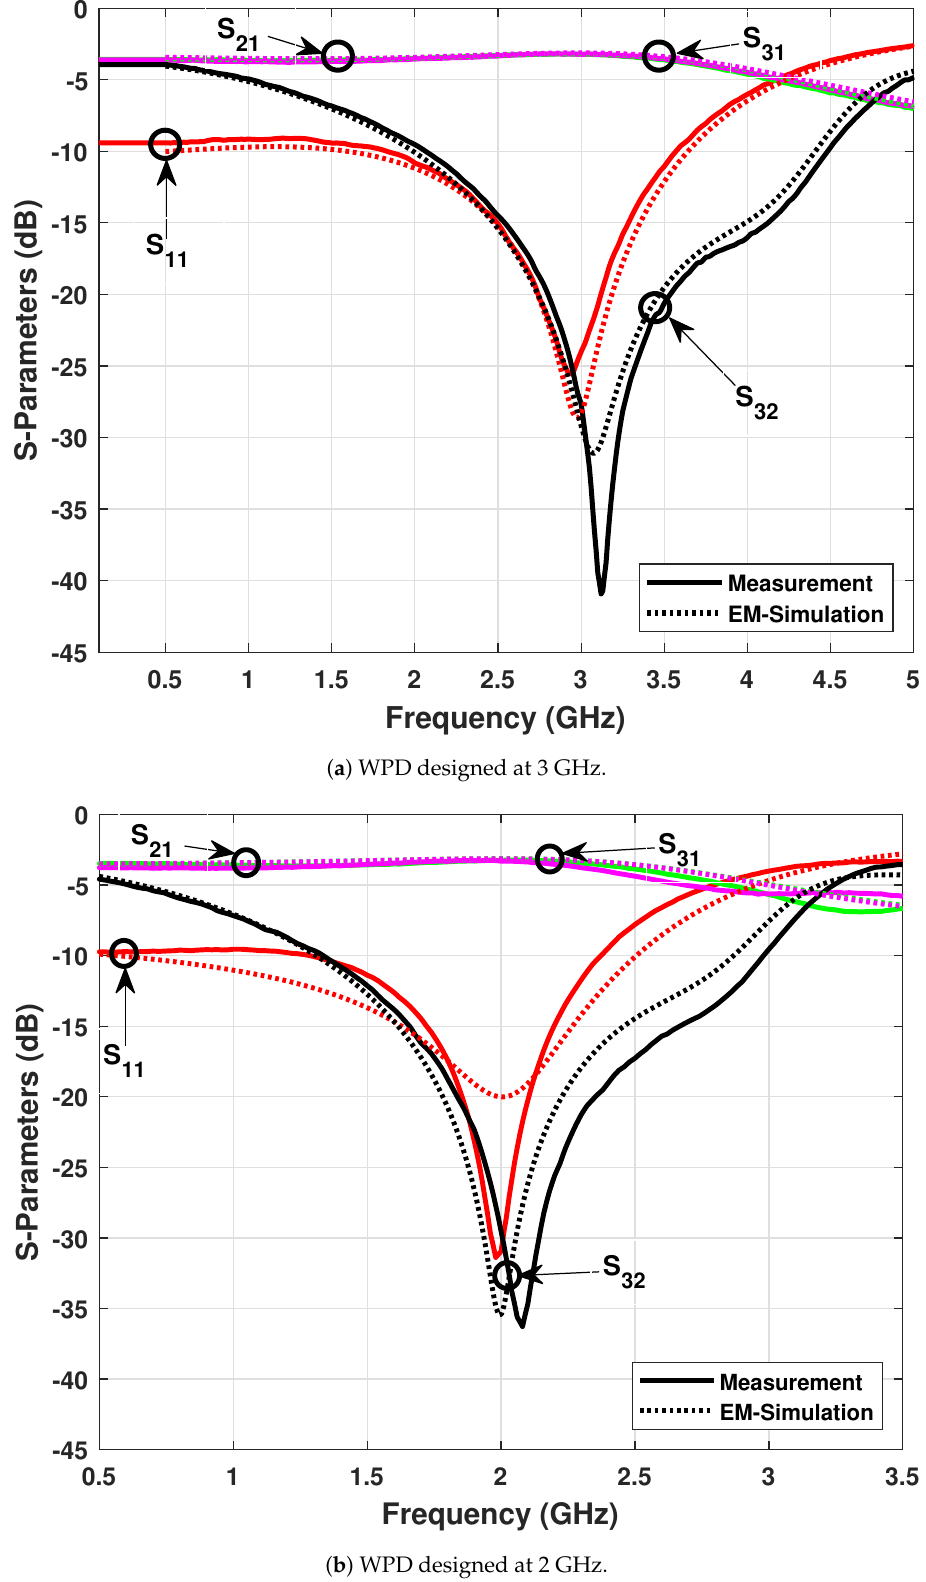
Figure 14. Simulated and measured S–parameters results of the proposed